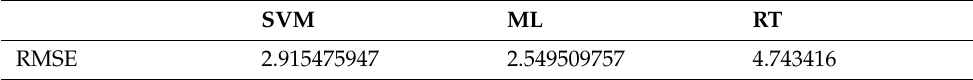
Table 8. RMSE for 2 class classification